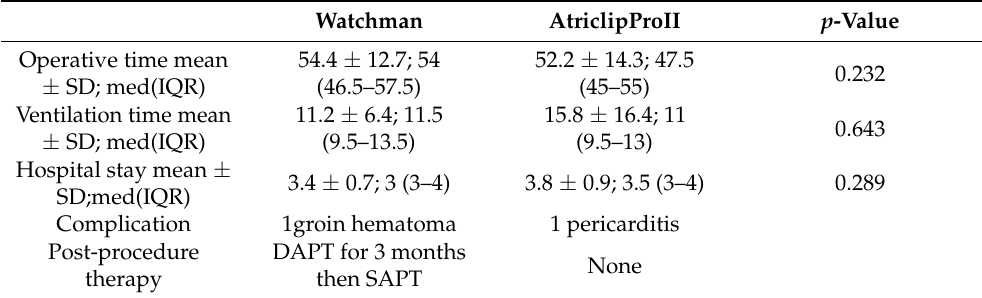
Table 3. Procedural data. Watchman AtriclipProII p